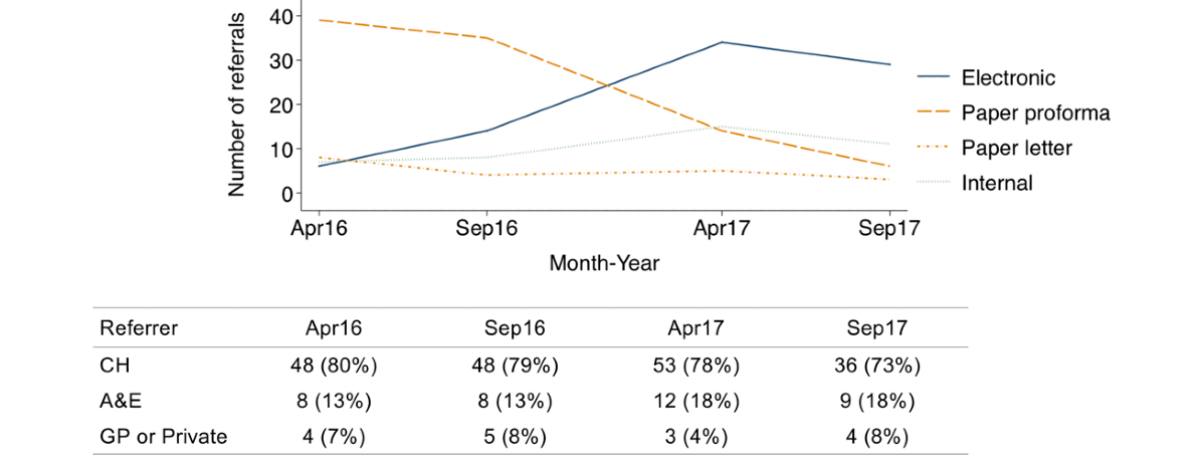
Figure 1. Number of monthly referrals per referral type (top line chart) and distribution of monthly referrals by referrer (bottom table) overtime, in April and September of 2016 and 2017. Patients with nonstandard (initially done as emergency neurosurgery referrals) or unknown referral source are not plotted (n=10). Internal refers to intrahospital referrals within the study center using the hospital’s electronic records system. CH: community hospital; A&amp;E: accidents and emergencies department of the study center; GP: general